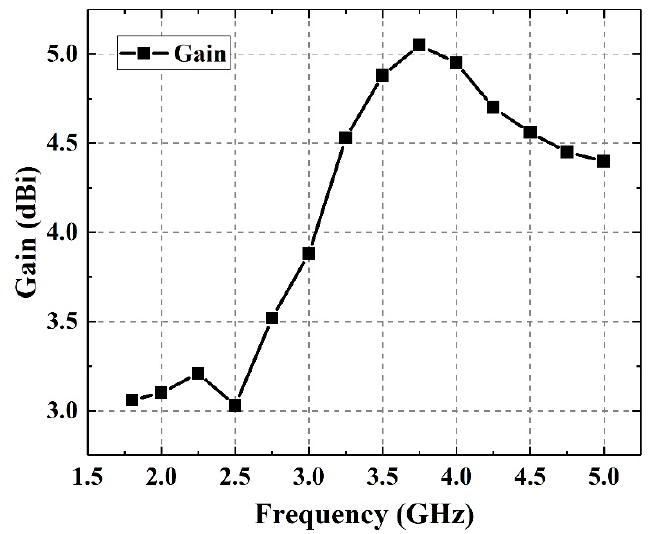
Figure 10. Measured results of antenna gain with frequency.